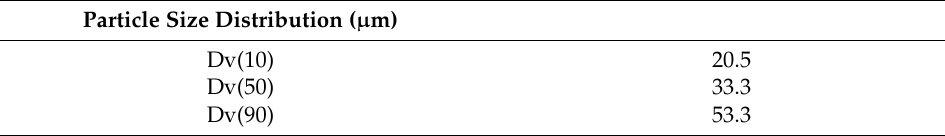
Figure 1. Scanning electron microscopy (SEM) micrograph showing the morphology of α -Al 2 O 3 powder used. Table 1. Size distribution of α -Al 2 O 3 particles used.